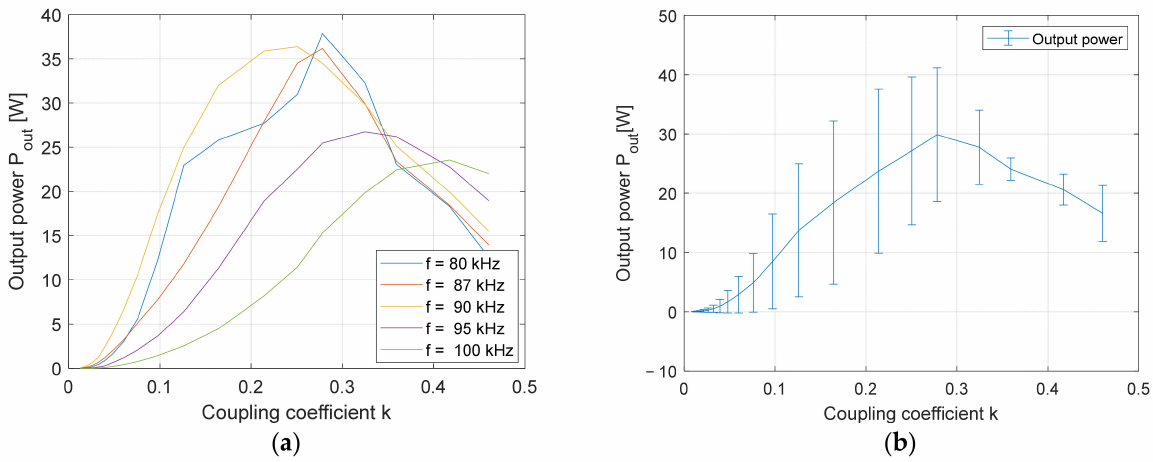
Figure 19. Output power of the IPT using the double DD coil structure: ( a ) at different frequencies; ( b ) average output power.